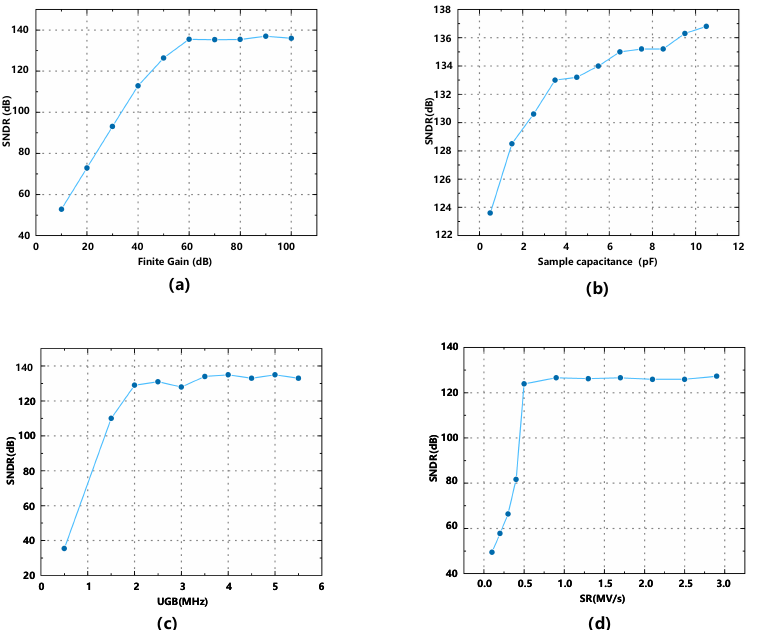
Figure 3. Impacts of circuit non-idealities to SNDR including ( a ) finite gain, ( b ) KT/C noise, ( c ) unit- gain-bandwidth, and ( d ) slew